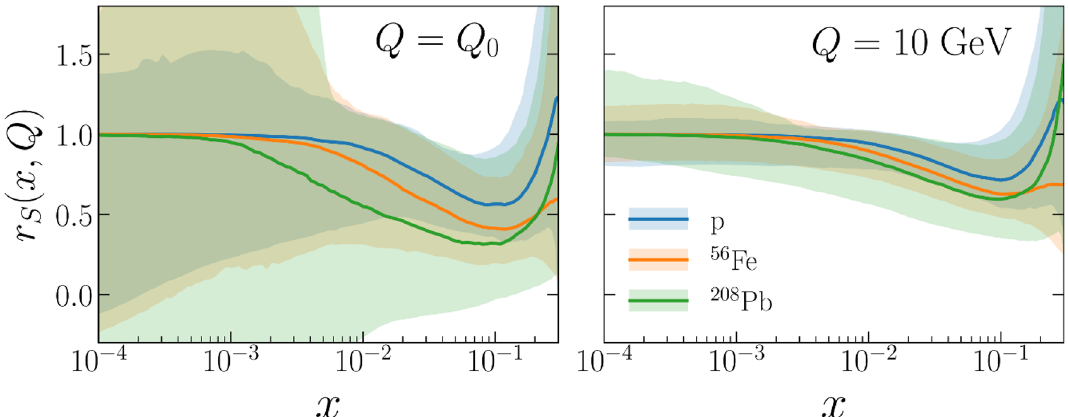
Figure 15 . The strangeness ratio r s ( x; Q 2 ), de(cid:12)ned in eq. (4.5), in nNNPDF2.0 comparing the results for the free-proton baseline, 56 Fe, and 208 Pb at both the input parametrisation scale Q 0 = 1 GeV (left) and at a higher scale Q = 10 GeV (right